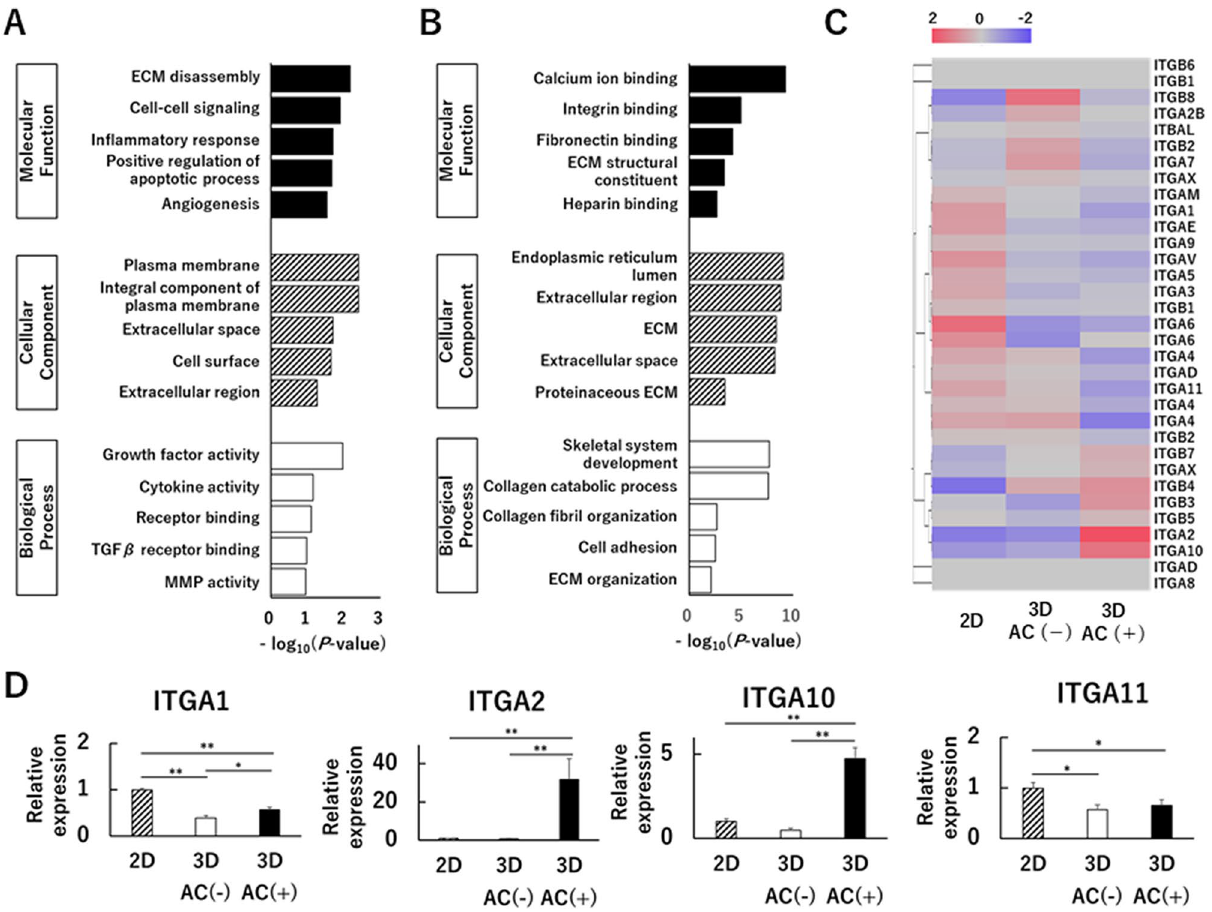
Figure 4. Atelocollagen gel significantly affects the expression of cell membrane- and extracellular matrix- related genes. ( A , B ) Gene ontology (GO) enrichment analysis comparing highly ranked (|log 2 FC|> 2) differentially expressed genes (DEGs) in 3D culture with atelocollagen gel and 3D culture without atelocollagen gel. ( A ) Enriched GO terms for the 1,863 genes upregulated in 3D culture with atelocollagen gel. ( B ) Enriched GO terms for the 2,056 genes down-regulated in 3D culture with atelocollagen gel. BP, biological process; CC, cellular component; MF, molecular function. ( C ) Heat map (logarithmic expression) of integrin family member genes presented in a mean enrichment plot across three culture groups. The mapped data were analyzed using the Subio platform version 1.24 (Subio, Inc., Kagoshima, Japan, http://www.subio .jp). ( D ) Comparison of expression of collagen-binding integrins. A representation of three independent experiments, each with three subjects and normalized expression relative to 2D culture cells at approximately 50–60% confluency (semi- confluent monolayers) is shown. * p < 0.05, ** p <